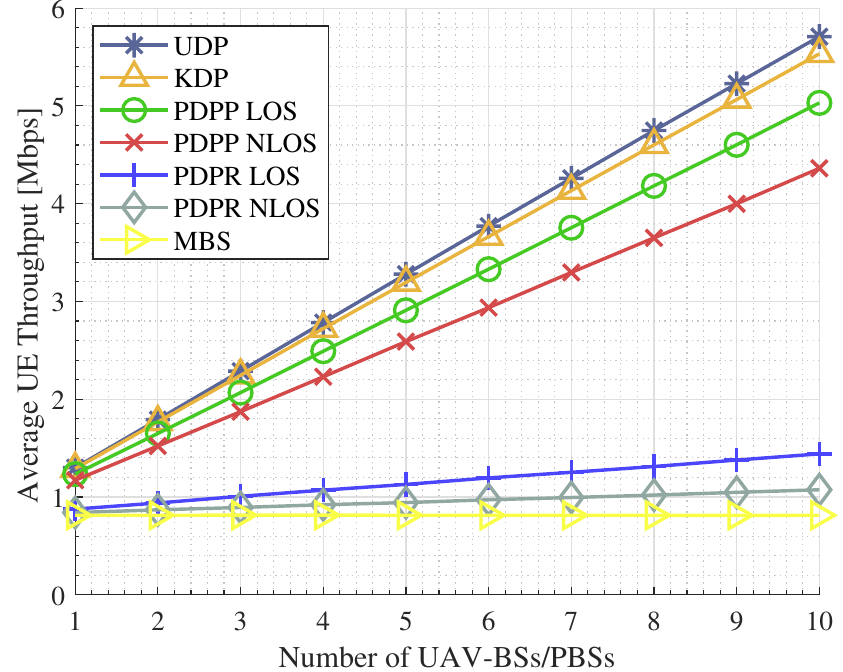
Figure 7. Average UE throughput for different number of UAV-BSs/PBSs.